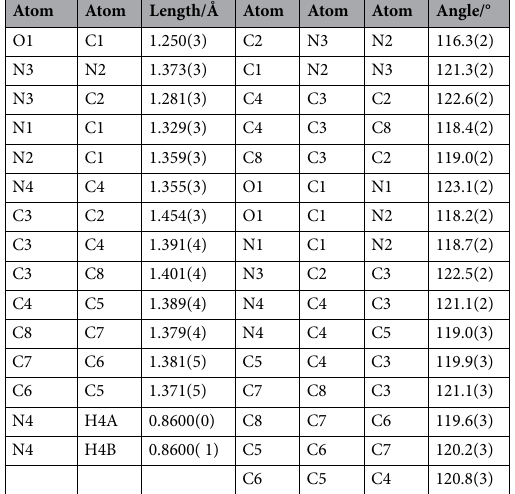
Table 1. Bond lengths and bond angles of compound